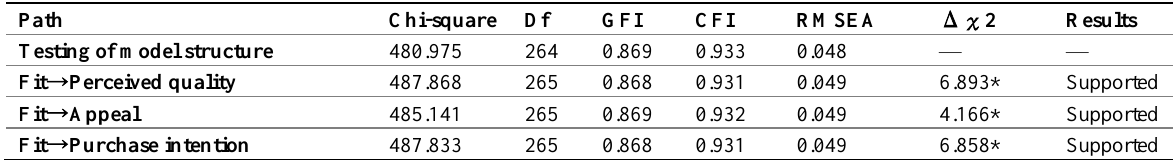
Table 16: The results of hypothesis testing for moderating